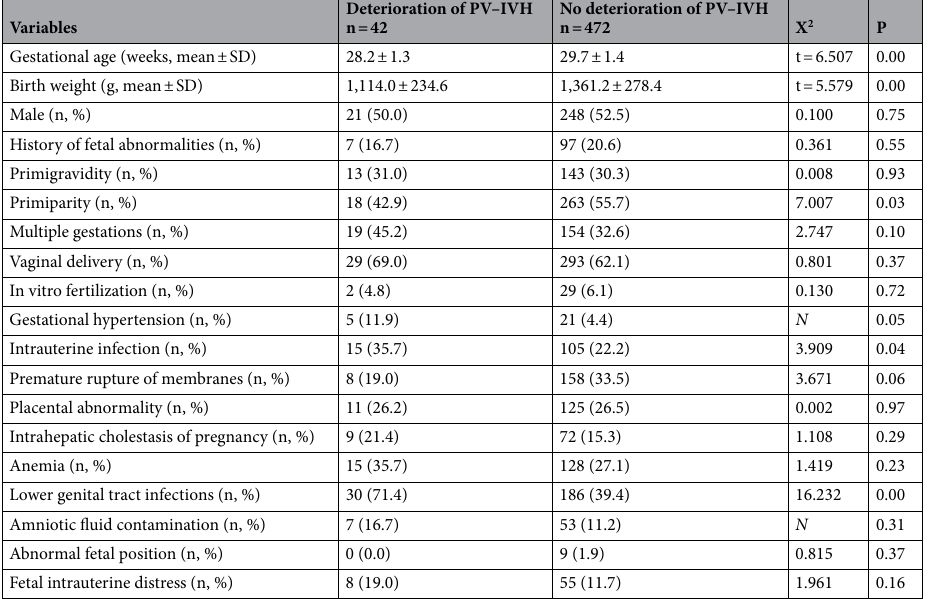
Table 1. Demographic features of preterm infants with PV–IVH. PV–IVH periventricular–intraventricular hemorrhage.